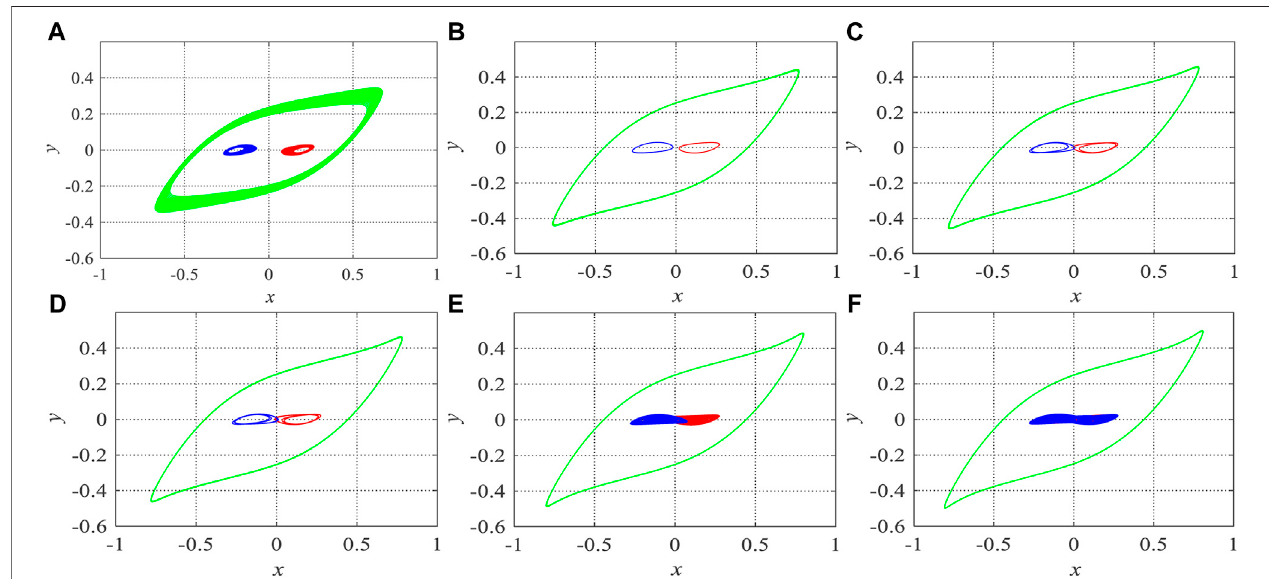
FIGURE 4 | Coexisting hidden attractors of Chua ’ s system, where the red attractors and blue attractors are those from Figure 3 , and the green attractors are the hidden attractors. (A) α (cid:1) 50, [ x 0 , y 0 , z 0 ] (cid:1) [0.3900, − 0.2065, 1.5600]; (B) α (cid:1) 60, [ x 0 , y 0 , z 0 ] (cid:1) [0.3200, − 0.1517, 1.0667]; (C) α (cid:1) 63, [ x 0 , y 0 , z 0 ] (cid:1) [0.3100, − 0.1440, 0.9841]; (D) α (cid:1) 63.8, [ x 0 , y 0 , z 0 ] (cid:1) [0.3100, − 0.1433, 0.9718]; (E) α (cid:1) 69, [ x 0 , y 0 , z 0 ] (cid:1) [0.2900, − 0.1305, 0.8406]; (F) α (cid:1) 72, [ x 0 , y 0 , z 0 ] (cid:1) [0.2900, − 0.1288, 0.8056].